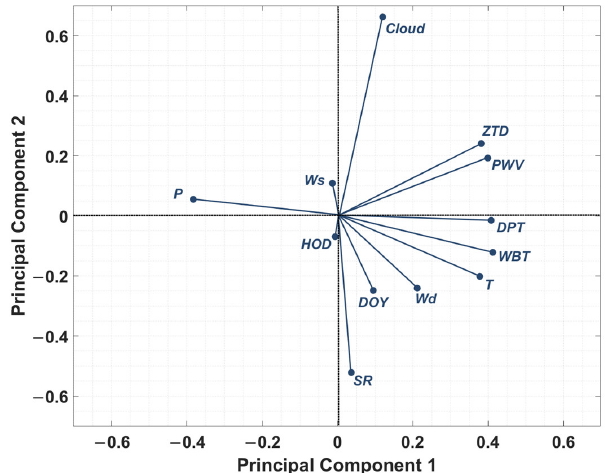
Figure 6. Biplot representation of the twelve input variables in the two principal component axes.